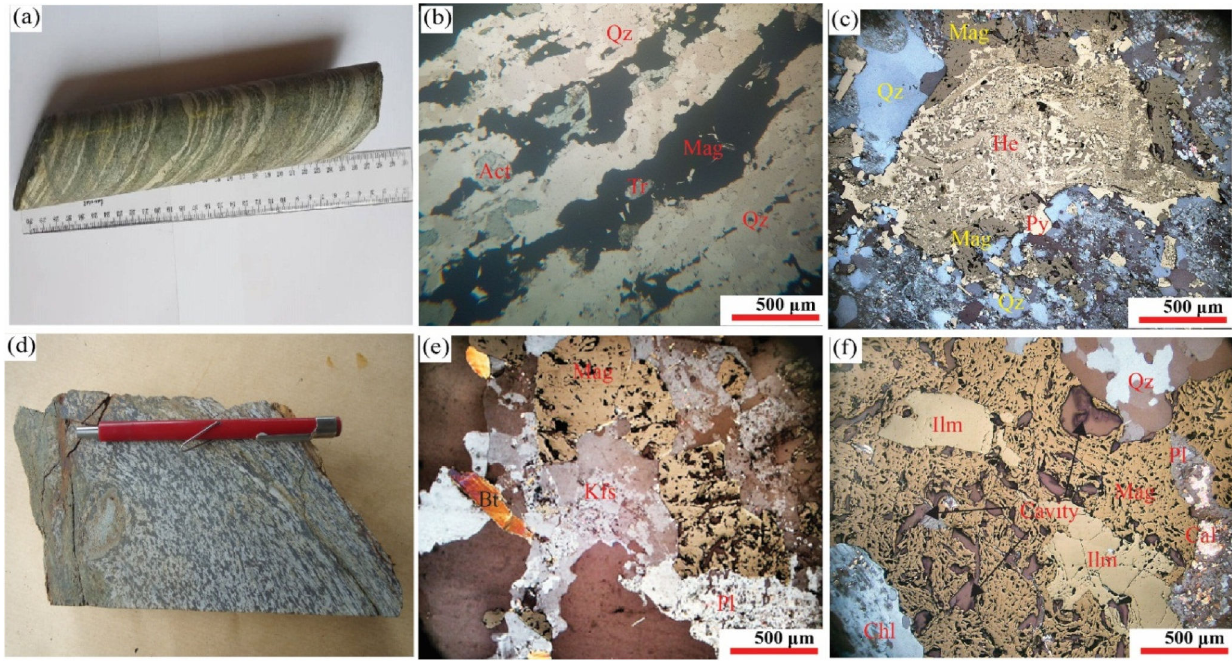
Figure 6. Drill core and photomicrographs (partially crossed and reflected light) of the Anyouzok IFs: ( a ) hand specimen of Banded iron formation (BIF) showing alternating silica and magnetite-rich bands; ( b ) photomicrograph of BIF showing granoblastic heterogranular microstructure; ( c ) anhedral magnetite crystal partially replaced by hematite and pyrite; ( d ) core specimen of SBIF; ( e ) granoblastic magnetite associated with biotite and intensely sericitized plagioclase and K-feldspar; ( f ) anhedral magnetite exhibiting several cavities, in association with ilmenite and secondary calcite. Abbre- viations: Act: actinolite; Mag: magnetite; Bt: biotite; Ilm: Ilmenite; Qz: Quartz; Cal: Calcite; Pl: Plagioclase; Kfs: K-feldspar; Py: pyrite; Chl: